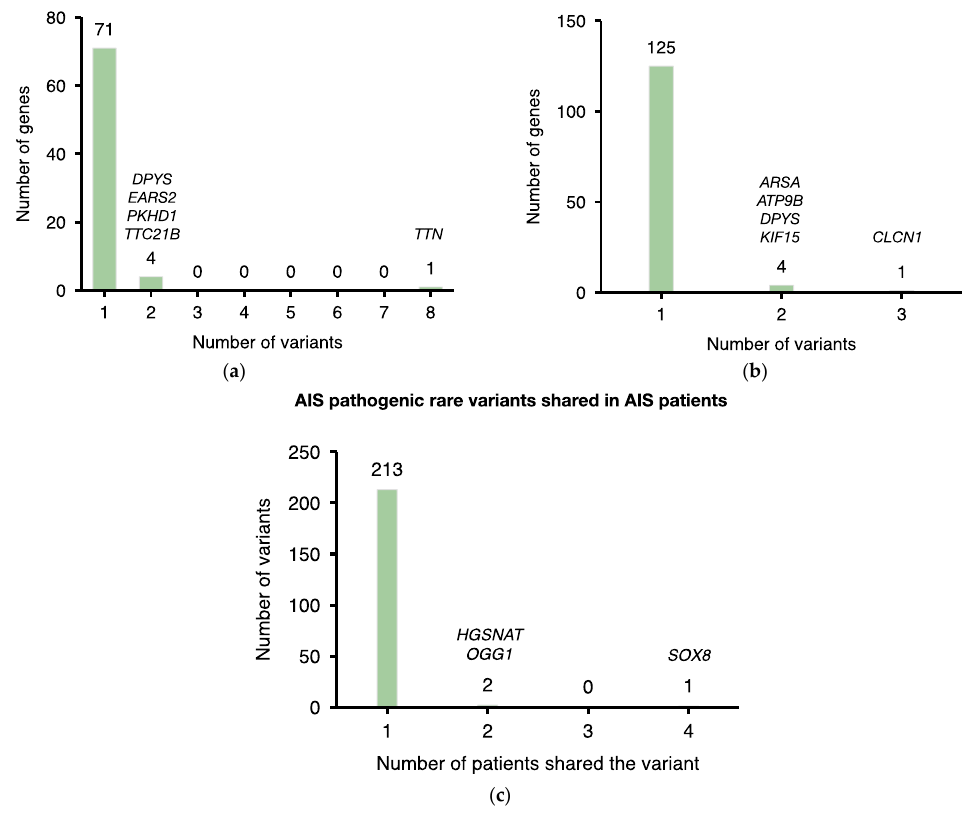
Figure 3. Summary of the pathogenic rare variants identified in 11 severe AIS patients. ( a ) AIS pathogenic rare variants predicted by ClinVar. ( b ) AIS pathogenic rare variants predicted by CADD and REVEL. ( c ) AIS pathogenic rare variants shared in AIS patients. Table 3. AIS pathogenic rare variants predicted by both ClinVar database and the CADD/REVEL scores.